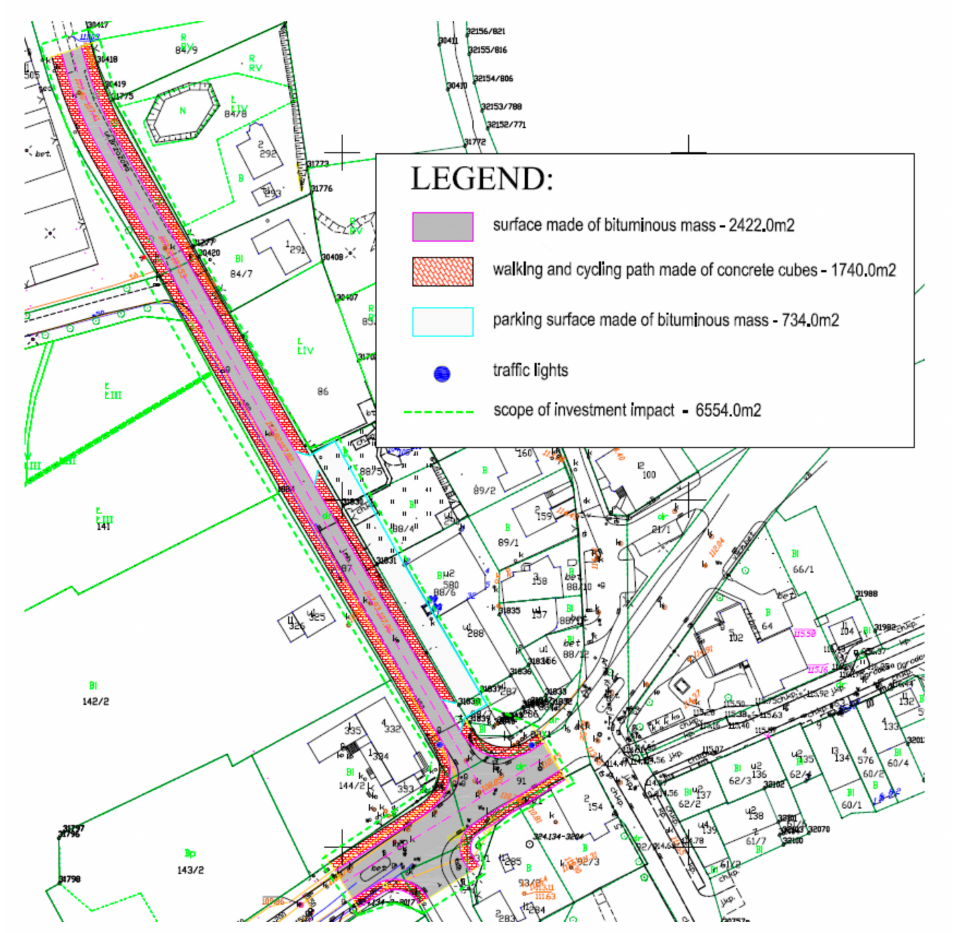
Figure 8. Site plan-proposed solution for the road layout at the intersection—option